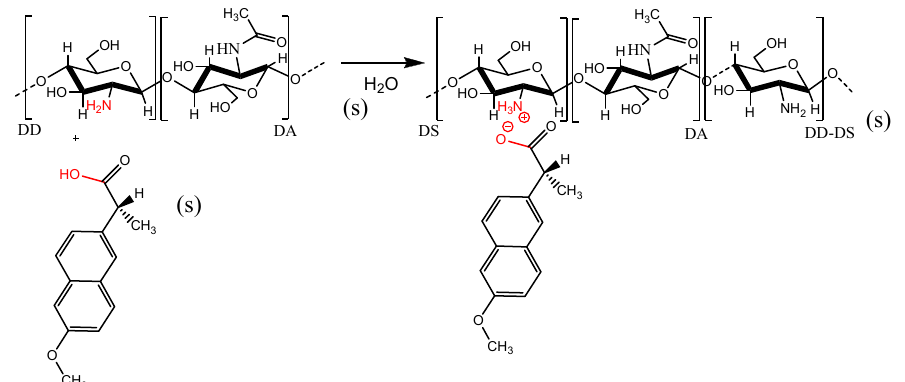
Figure 7. Scheme proposed for the reaction between CTS and NAP for preparation of the CN salt. Optimized reaction parameters: temperature 40/60 °C; reaction time 24/48 h; CTS:NAP mol ratios of 1:1.05 and 1:1.50 ( mol / mol ).